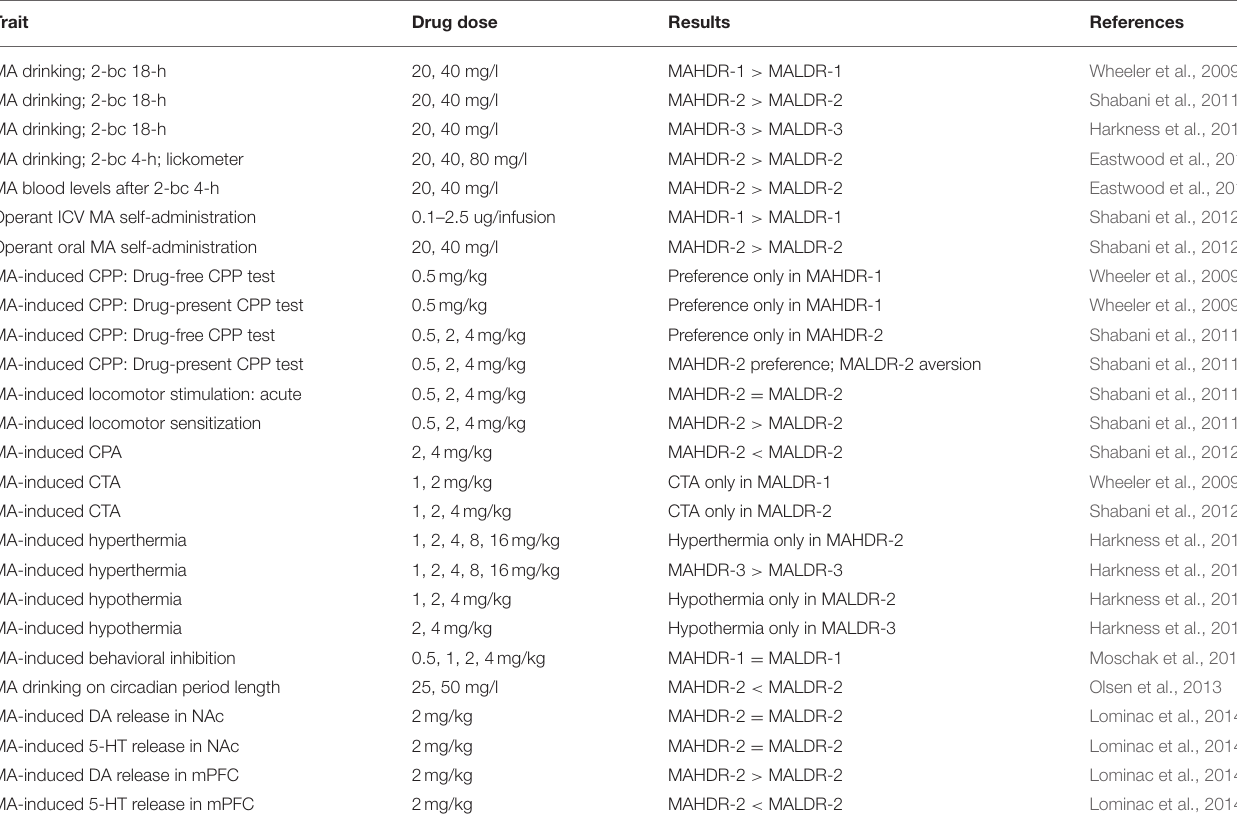
TABLE 1 | Published MA traits characterized in the MA drinking